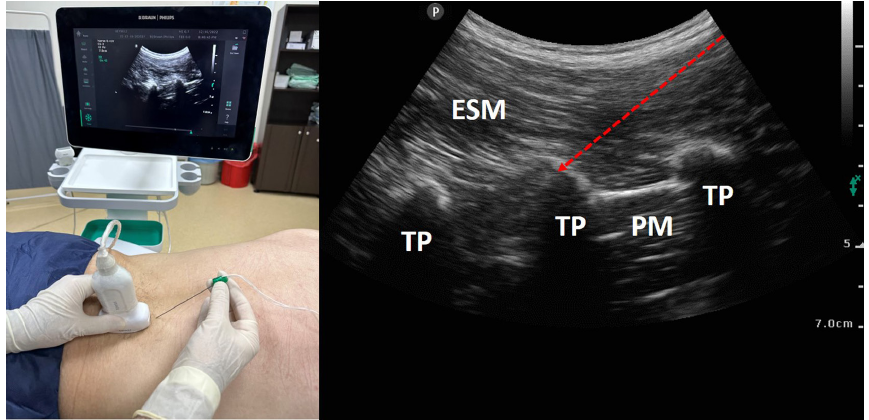
Figure 7. A, B. (A) Patient and ultrasound probe position for lumbar erector spinae plane block procedure. (B) Sonographic anatomy of the block. ESM, erector spinae muscle; PM, psoas muscle; TP, transverse process; red arrow,